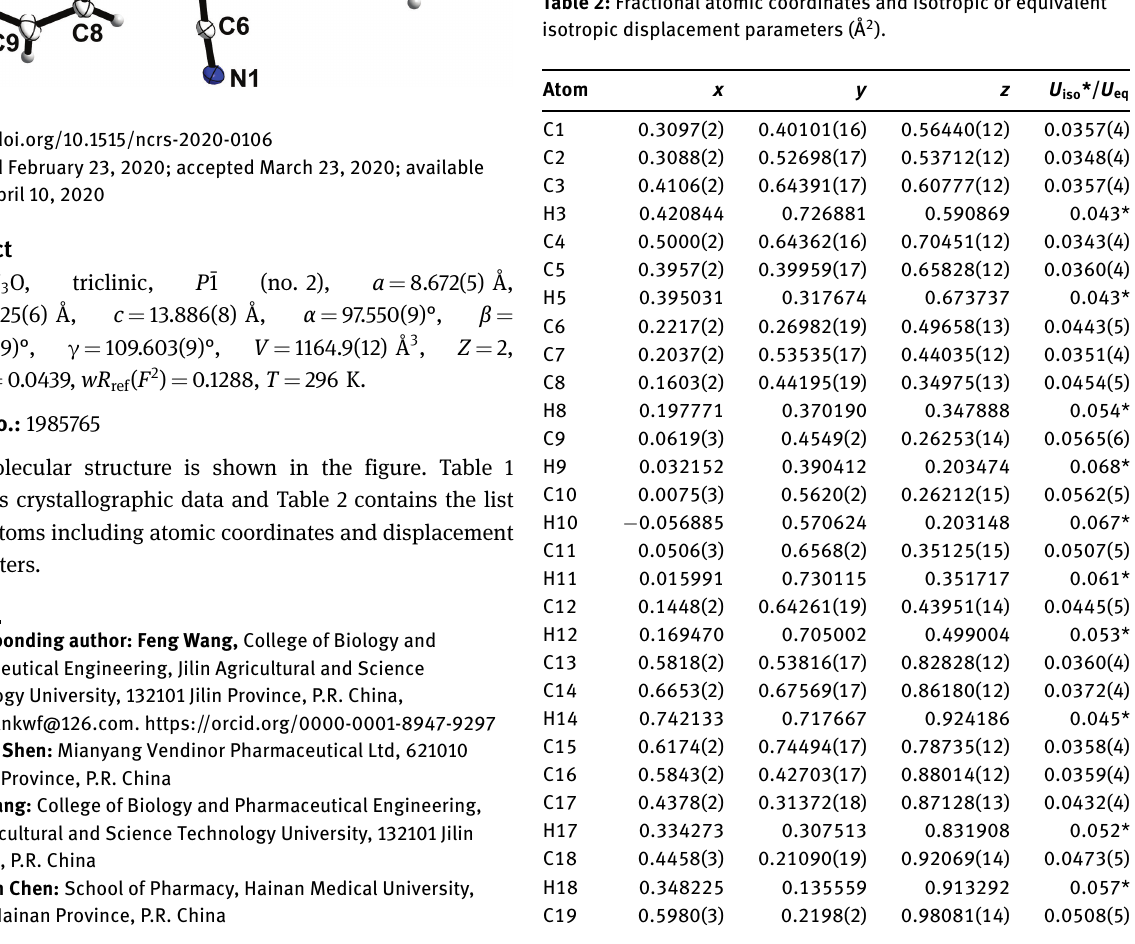
Table 2: Fractional atomic coordinates and isotropic or